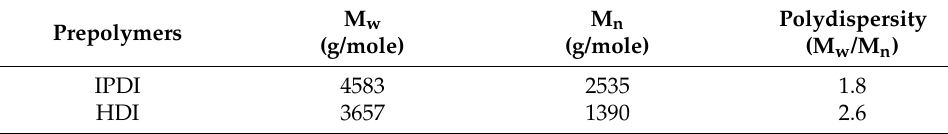
Figure 9. Gel permeation chromatography (GPC) curves of prepolymers. Table 1. Molecular weight and polydispersity of